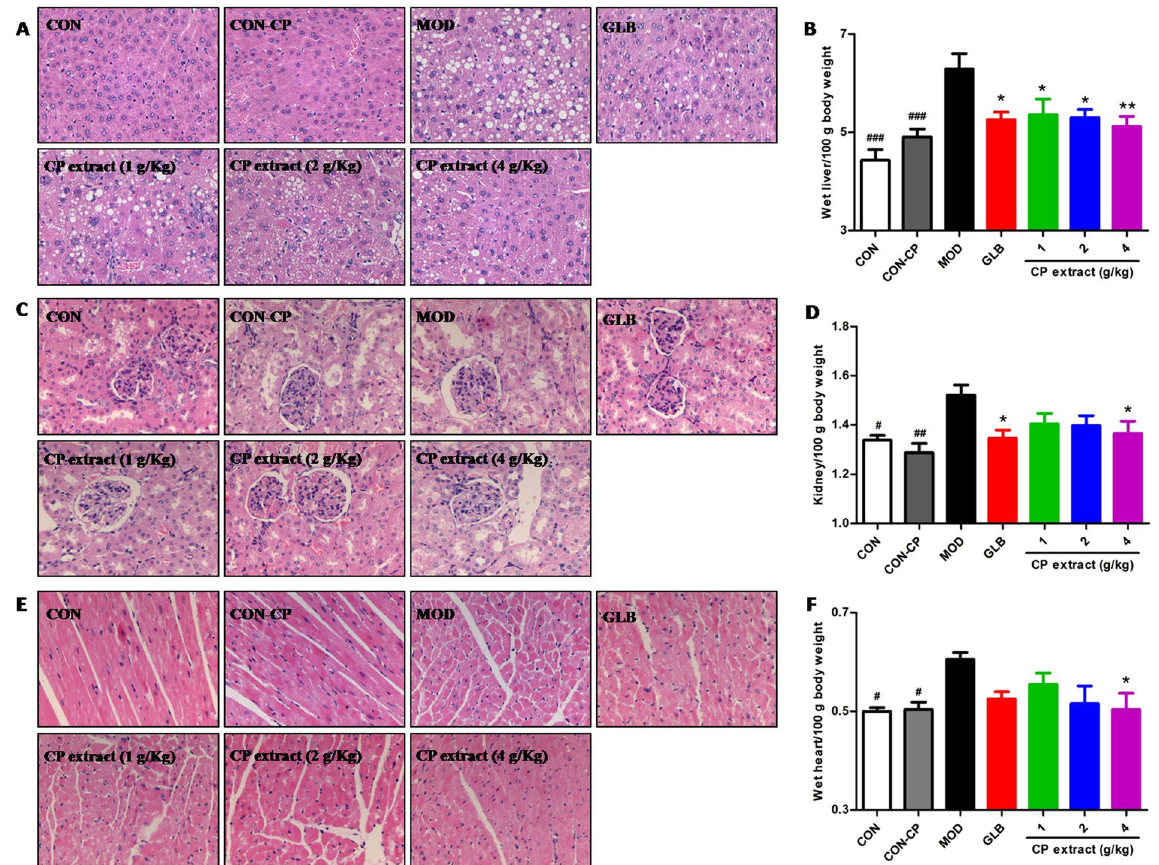
Figure 8. CP extract reduces chronic hyperglycemia-induced damages in liver, kidney and heart of diabetic mice. The type 2 diabetic mice were induced by feeding with high-fat diet for 4 weeks and then injecting intraperitoneally with 25 mg/kg STZ for 3 days consecutively. The diabetic mice with consecutive 7-day hyperglycemia (11 mmol/L or greater) were selected for the experiment and then CP extract or glibenclamide were administered to mice for consecutive 5 weeks. At the end of experiment, mice were sacrificed. The samples of liver, kidney and heart tissues were collected. Histopathological examination of liver ( A ), kidney ( C ) and heart tissues ( E ) (H & E staining) (magnification, 100 × ); Relative weight of wet liver ( B ), kidney ( D ) and heart tissues ( F ). All data are presented as means ± SEM (n = 8). # p < 0.05, ## p < 0.01 and ### p < 0.001, diabetic model group compared with non-diabetic groups; * p < 0.05 and ** p < 0.01, compared with diabetic model group. CON: non-diabetic control group; CON-CP: CP extract-treated non-diabetic control group; MOD: diabetic model group; GLB: glibenclamide-treated diabetic